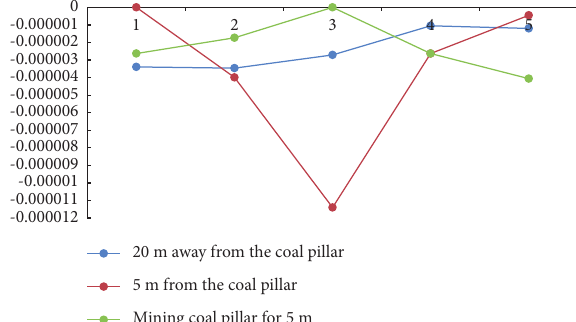
Figure 14: Comparison of vertical stress of the lower coal seam mining.